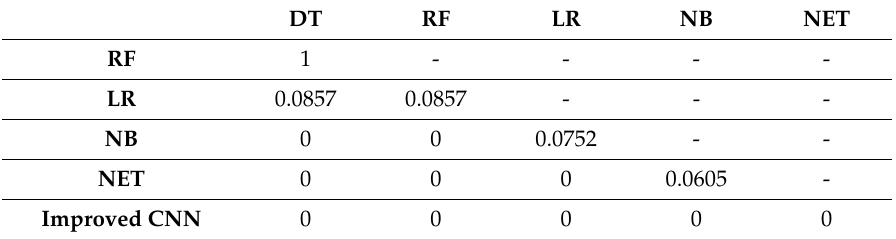
Table 9. Holm–Bonferroni test of prediction on the PSC dataset for F-measures.